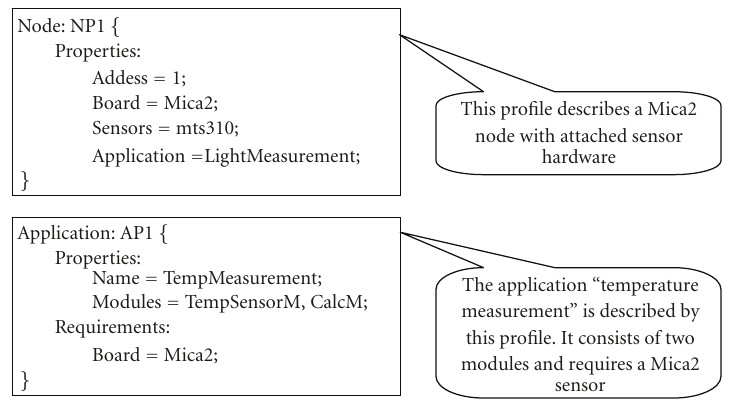
Figure 4: Sample profiles describing HW/SW configuration of sensor nodes and application requirements.